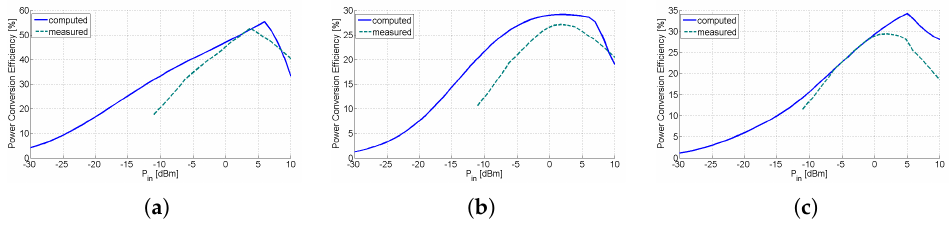
Figure 11. Efficiency versus RF input power level of the proposed RF-to-DC rectifier (Computed results are displayed in blue solid line, whereas measured results are displayed in dark green dash line) ( a ) freq = 866.4 MHz, ( b ) freq = 1841 MHz, and ( c ) freq = 1957